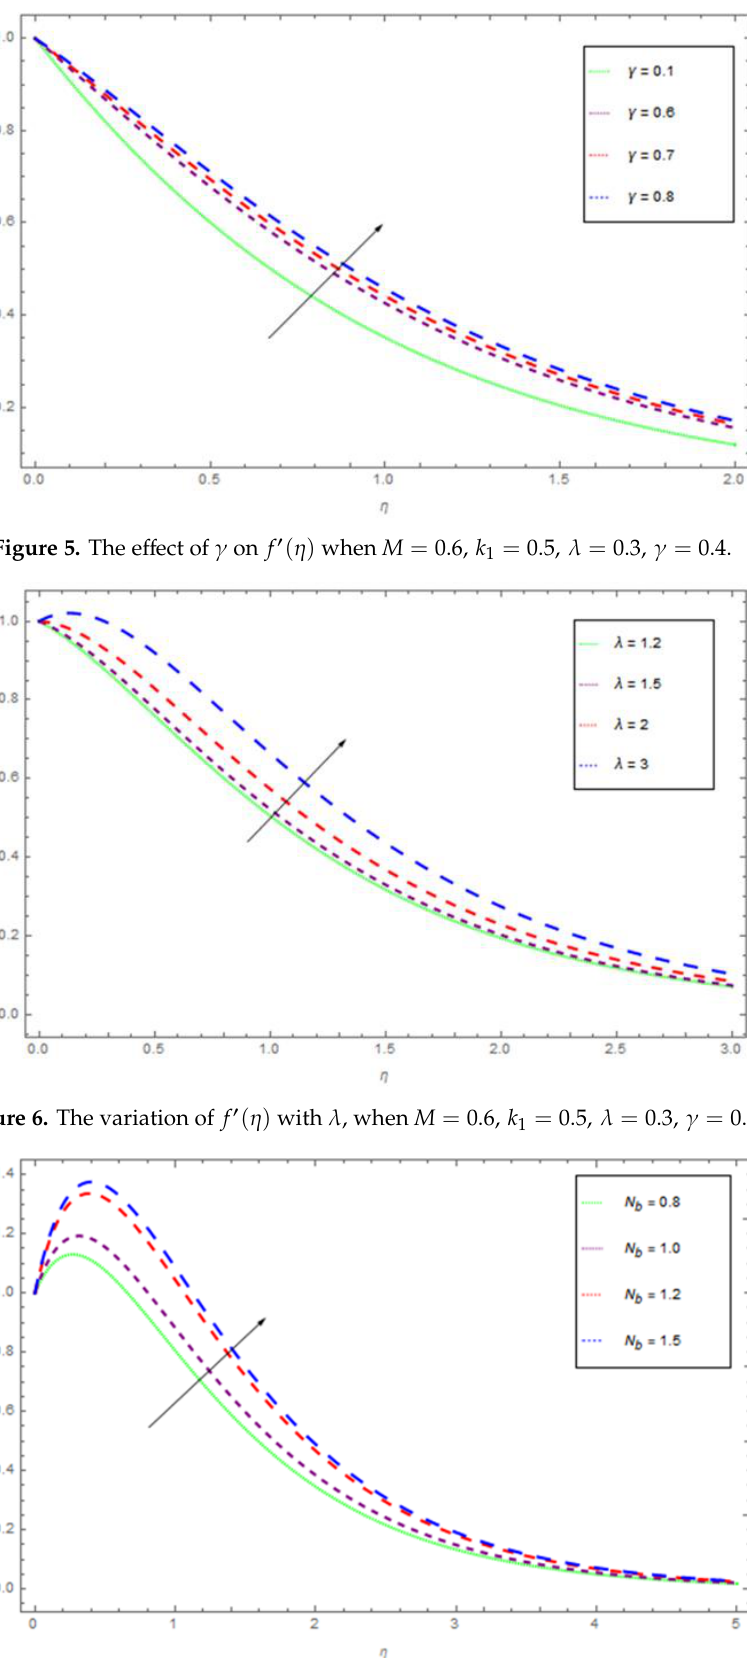
Figure 7. The influence of N b on θ ( η ) when γ = 0.8, Pr = 4, N t =